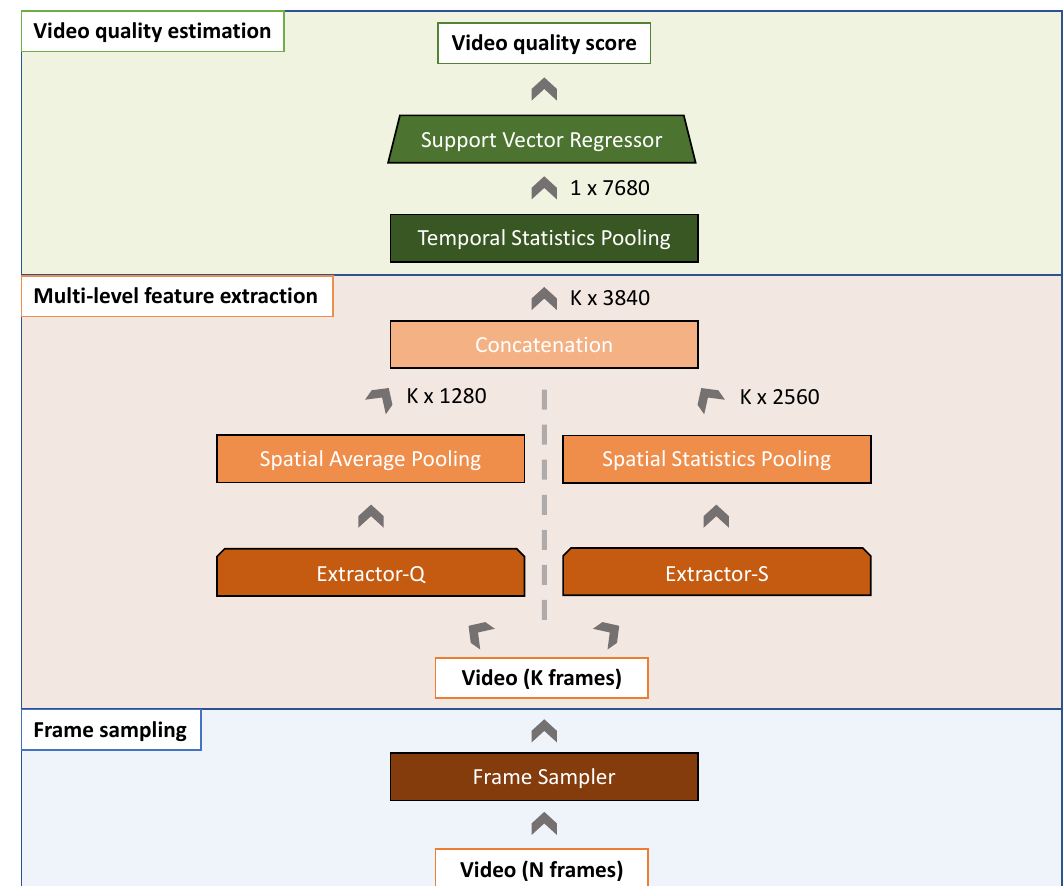
Figure 2. Our NR-VQA method consists of three main steps: the Frame sampling, the Multi-level feature extraction, and the Video quality estimation. In the Frame sampling, a set of K frames is first sampled from the whole video. These K frames are then encoded in terms of both quality and semantic features in the Multi-level feature extraction step. The Video quality estimation block aggregates the frame-level feature vectors into a video-level feature vector using a Temporal statistic pooling and then estimates the quality score using a Support Vector